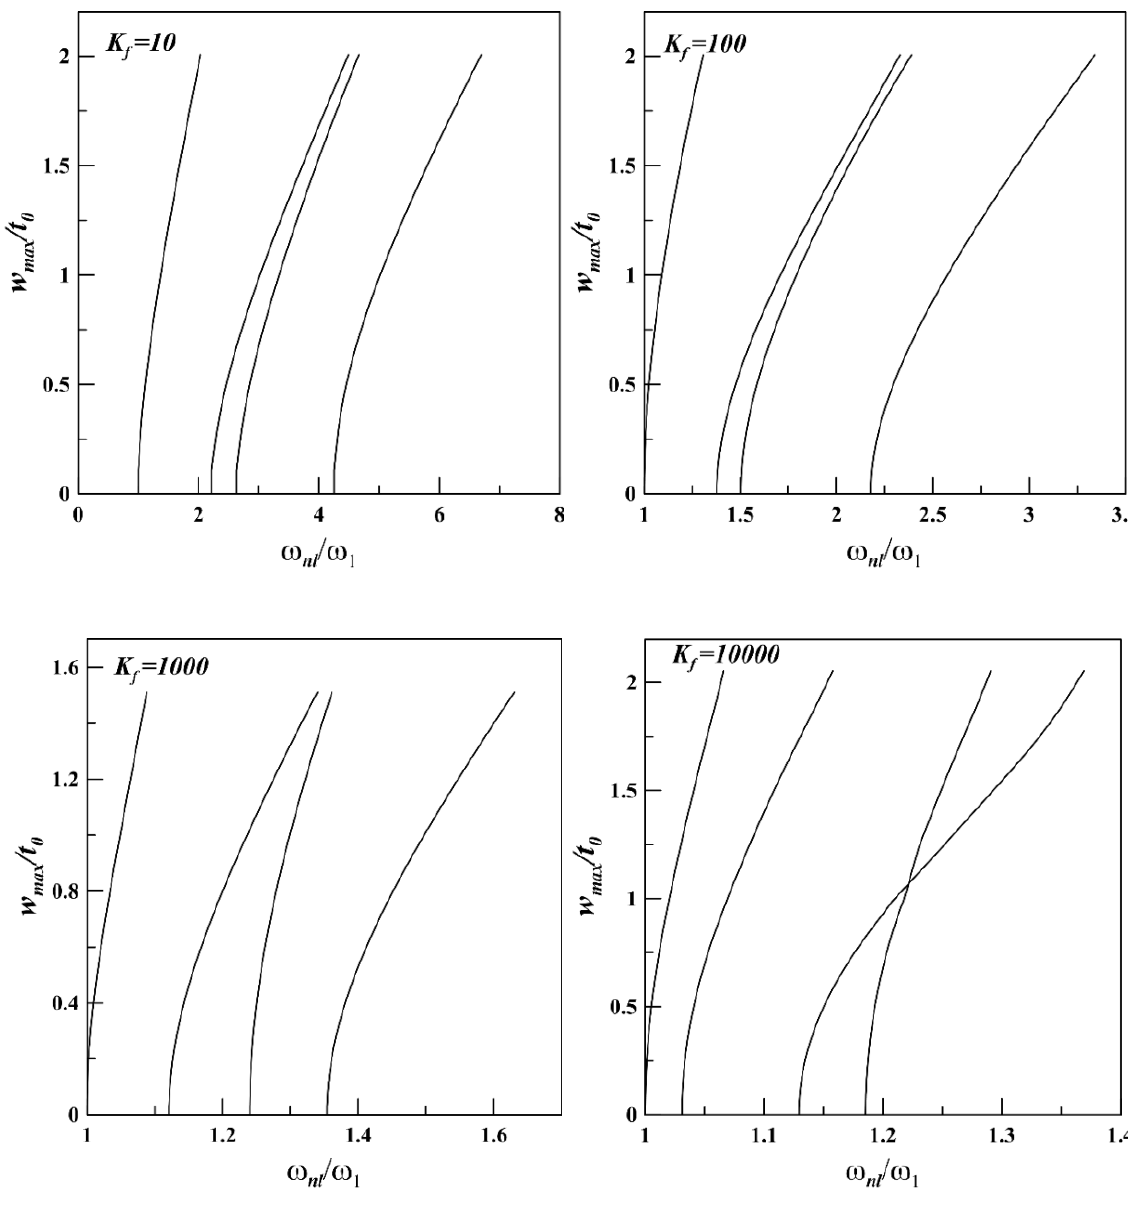
Figure 6: Backbone curves of CCFF plate for various foundation stiffness at α , β =